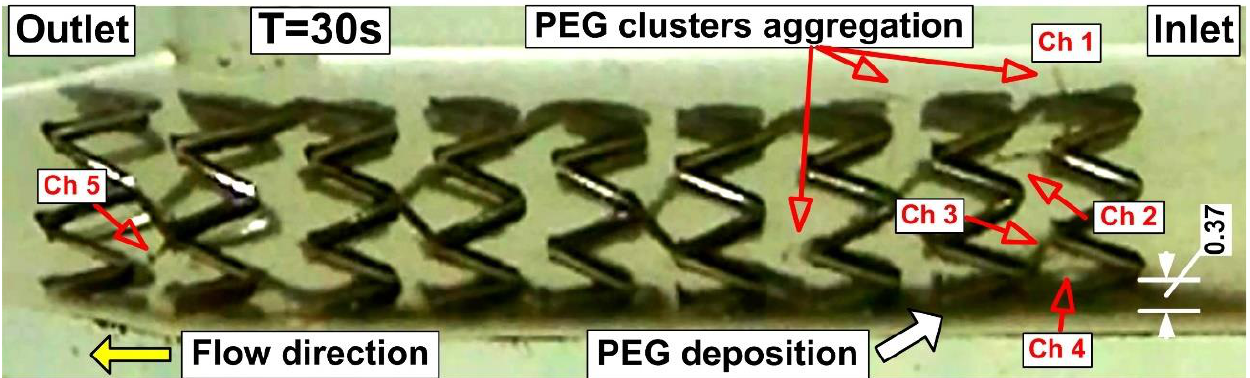
Figure 1. Flow-oriented large-scale magnetically induced aggregation of the PEG_MNC in the targeted region (red arrows) at the end of the injection period of 30 s. Magnetic cluster depositions correspond to the permanent magnet positions of 15 mm from the stent’s bottom wall. Ch 1 ÷ Ch 5–chain-like magnetic particles structure, generated in a different part of the stent geometry in the presence of the external magnetic field. Particle depositions on the bottom wall of the artery model in the stent inlet section (0.37 mm) at the end of the injection period of 30 s.